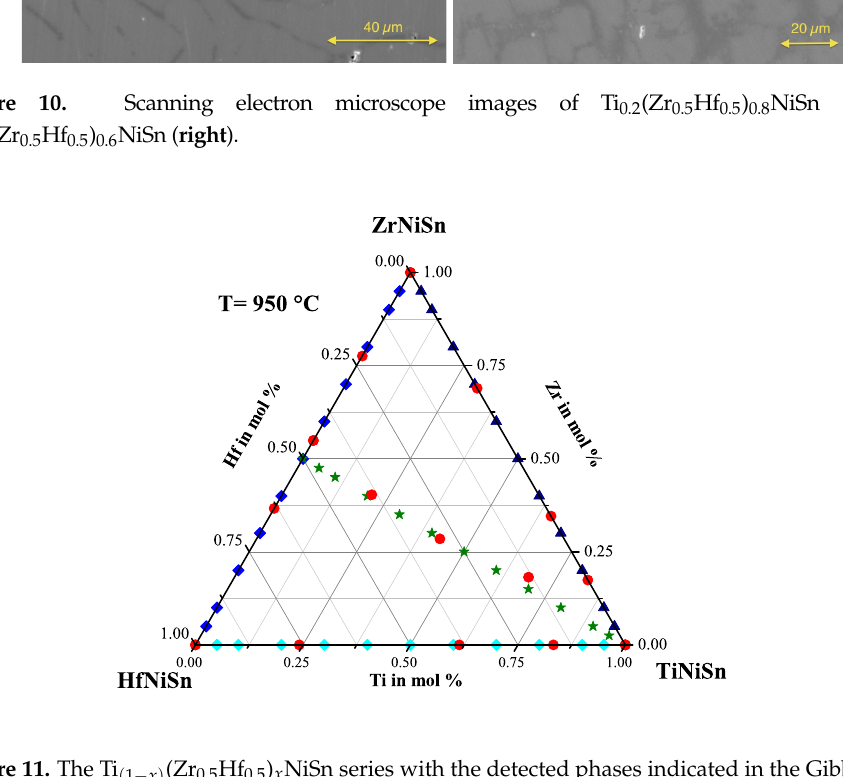
Figure 11. The Ti ( 1 − x ) (Zr 0.5 Hf 0.5 ) x NiSn series with the detected phases indicated in the Gibbs triangle. Table 7. The phase compositions of the different Ti ( 1 − x ) (Zr 0.5 Hf 0.5 ) x NiSn samples and the parent samples. Weighed